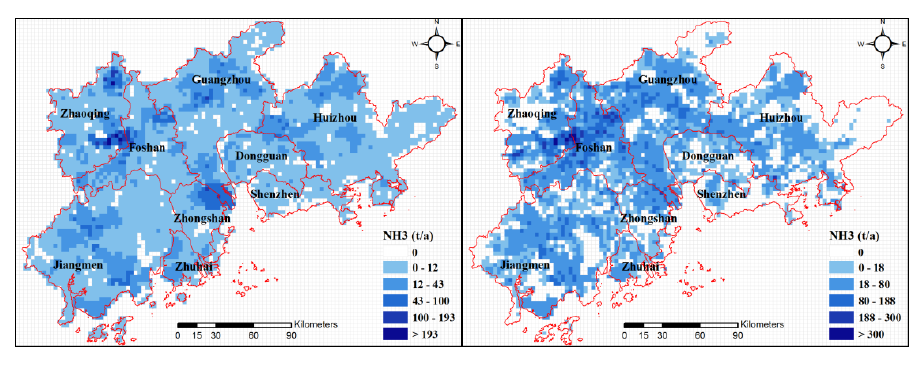
Fig. 6. Spatial distributions of NH 3 emissions by source category in the PRD